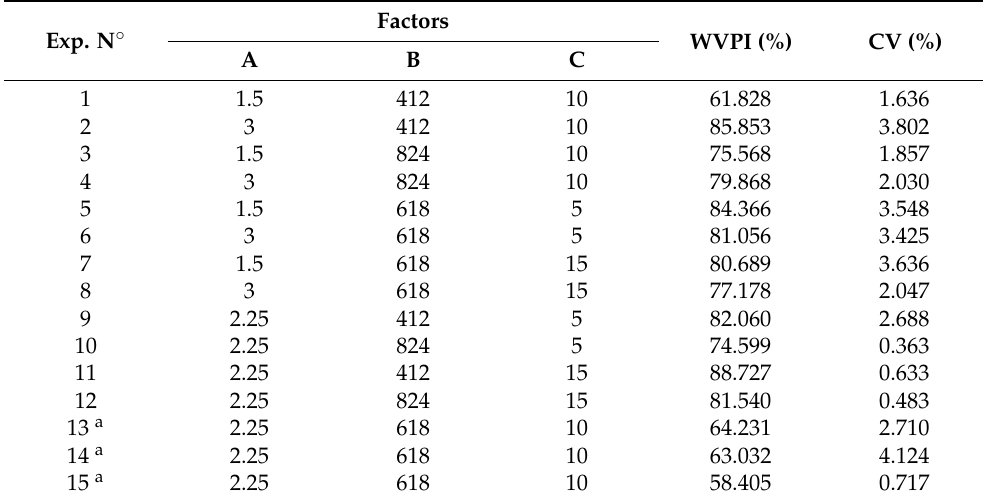
Table 5. Water vapor permeability indexes for the treated